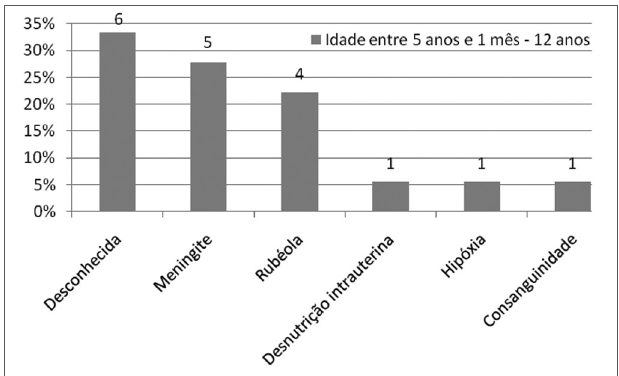
Figura 13. Distribuição etiológica dos pacientes implantados na faixa etária entre 5 anos e 1 mês e 12 anos.